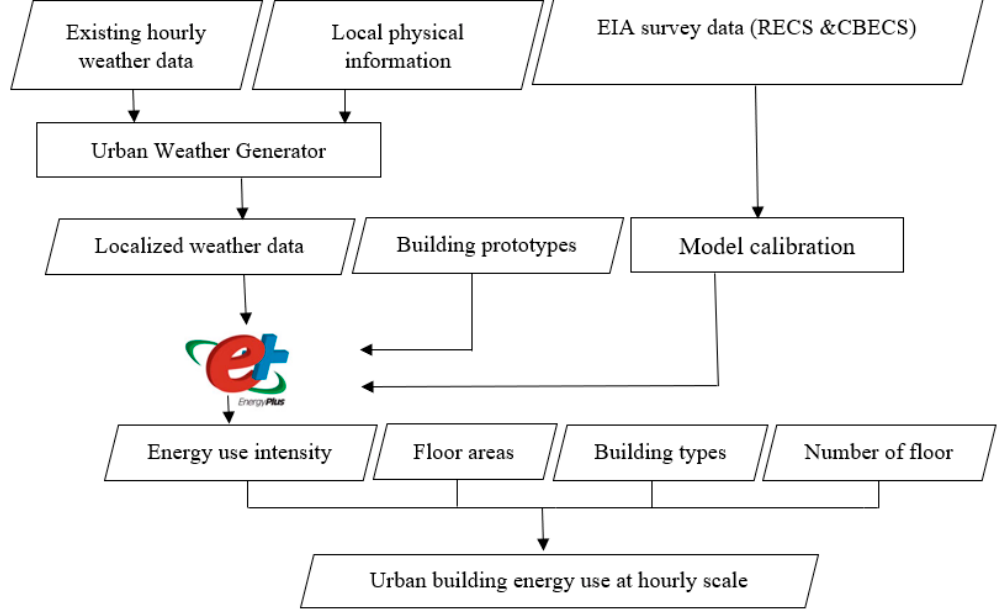
Figure 2. Flow chart of the proposed study.